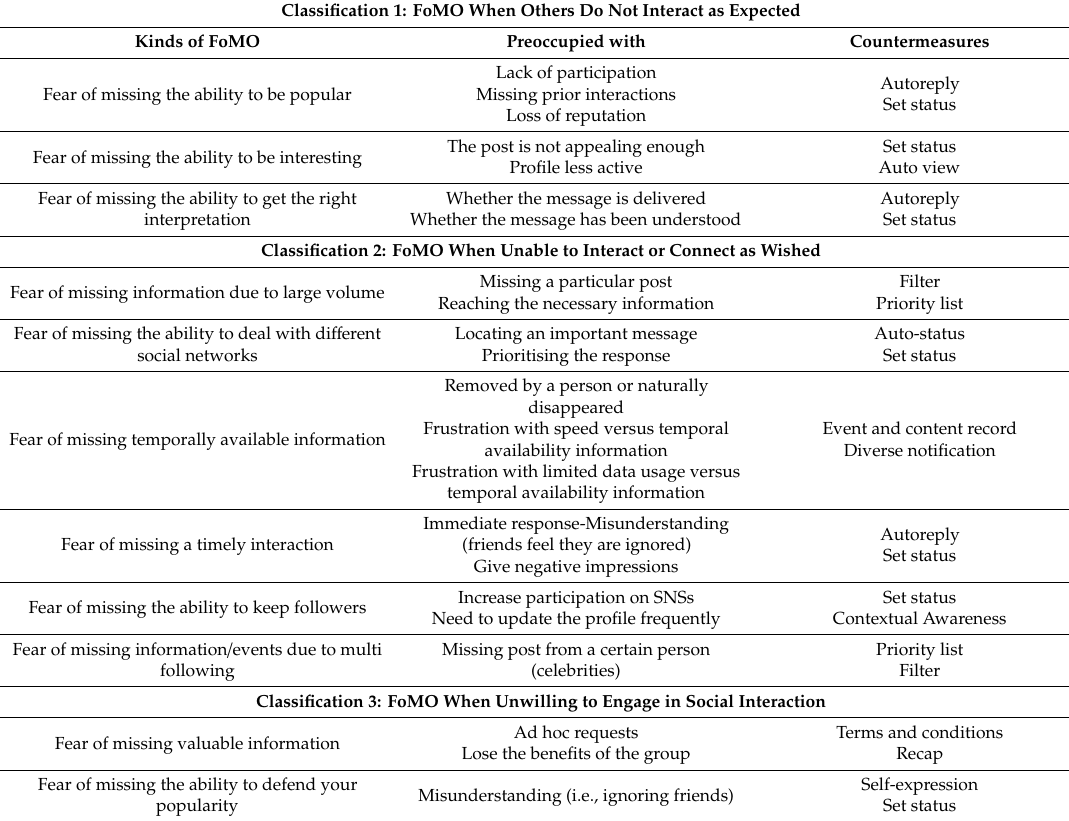
Table 1. FoMO: context classifications, fears and countermeasures (summary of [2,18,19]). Classification 1: FoMO When Others Do Not Interact as Expected Kinds of FoMO Preoccupied with